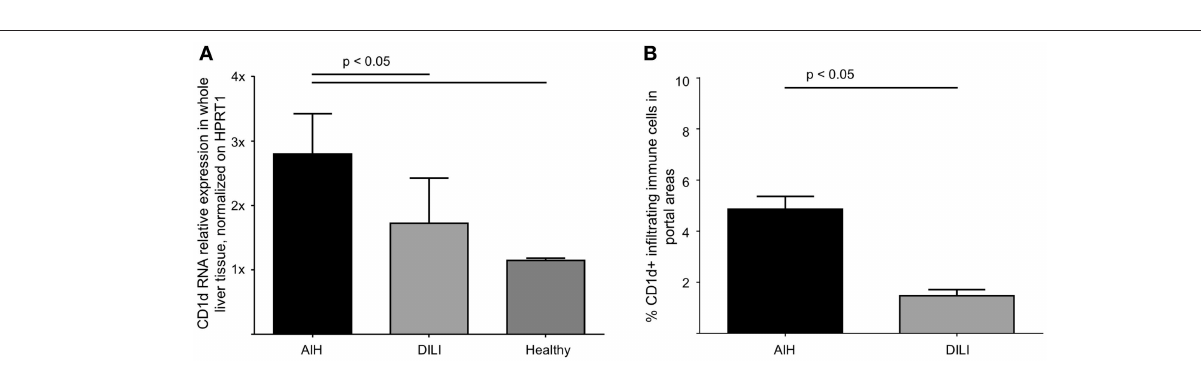
16.4% of CD1d + portal cells were CD8 + , median value 9.9%; Figure 10C